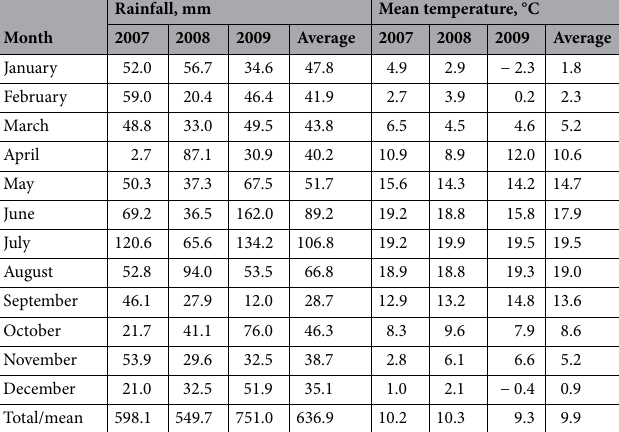
by hand, then, the plots were raked and a smooth roller was applied. In the experiment 12 grass mixtures were used (Table 2). Mixtures M1–M5 were available in the commercial offer, with the predominating varieties of red fescue in the species composition. Mixtures M6–M12, in which Lolium perenne L. and Poa pratensis L. varieties dominated, were purposefully prepared in the Department of Meadows and Green Area Creation in Wrocław University. The first mowing was done when the grass was 8 cm tall, and subsequent ones were carried out 1–2 times a week at a height of 3 cm. Turf, depending on the weather, was irrigated with 6 L m −2 of water per day. During each growing period, NPK mineral fertilizers were used in a ratio of 6:2:4, at the following doses: N—180 kg ha −1 ;